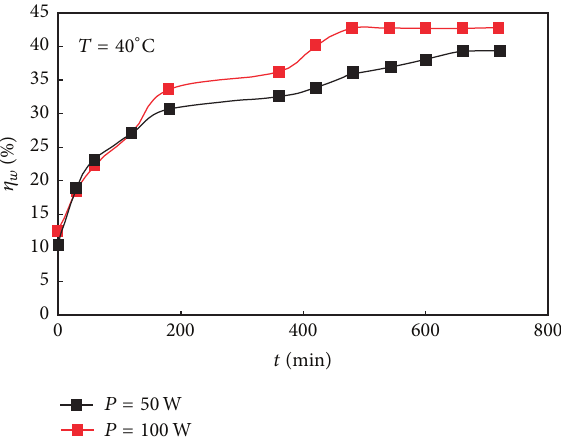
Figure 10: The impact of ultrasonic power (100W and 150W) on sonochemistry